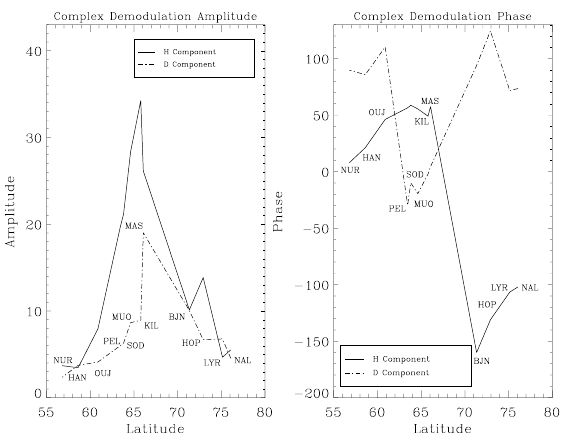
Fig. 15. Complex demodulation H and D -component amplitude and phase for the 3.2mHz wave (average of 2 demodulates centred around